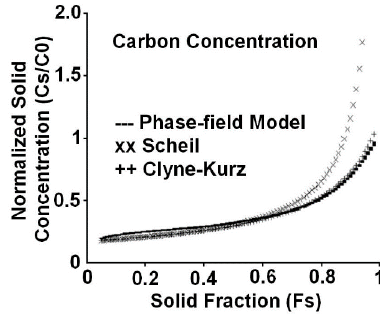
Figure 8. Comparison of carbon concentration as evaluated: via the phase-field model; with Scheil’s equation; and with the Clyne-Kurz equation.